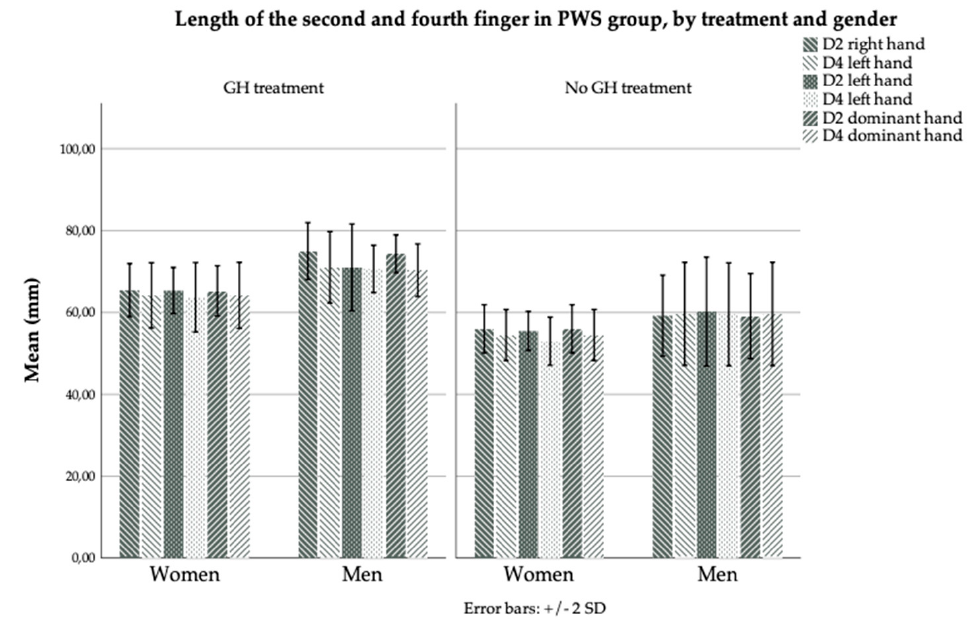
PWS = Prader–Willi Syndrome volunteers. PWS-GH = PWS participants on treatment with GH dur- ing the childhood/adolescent period. PWS-NoGH = PWS participants without GH treatment during the childhood/adolescent period. Statistics U = Mann–Whitney U; signification. m (SD): Mean (standard deviation). M (ITQ): Median, Inter-quartile range (25–75). mm = Millimeters. 2D = second finger, index. 4D = Fourth finger, annular. 2D:4D = second finger/fourth finger ratio. * Signification PWS participants with GH treatment during childhood/adolescence vs. controls. ** Signification PWS participants without GH treatment during childhood/adolescence vs. controls. *** Signification PWS participants with GH treatment during childhood/adolescence vs. PWS participants without GH treatment during childhood/adolescence. R hand = Right hand. L hand = Left hand. D hand: Dominant hand. Bold is significant.